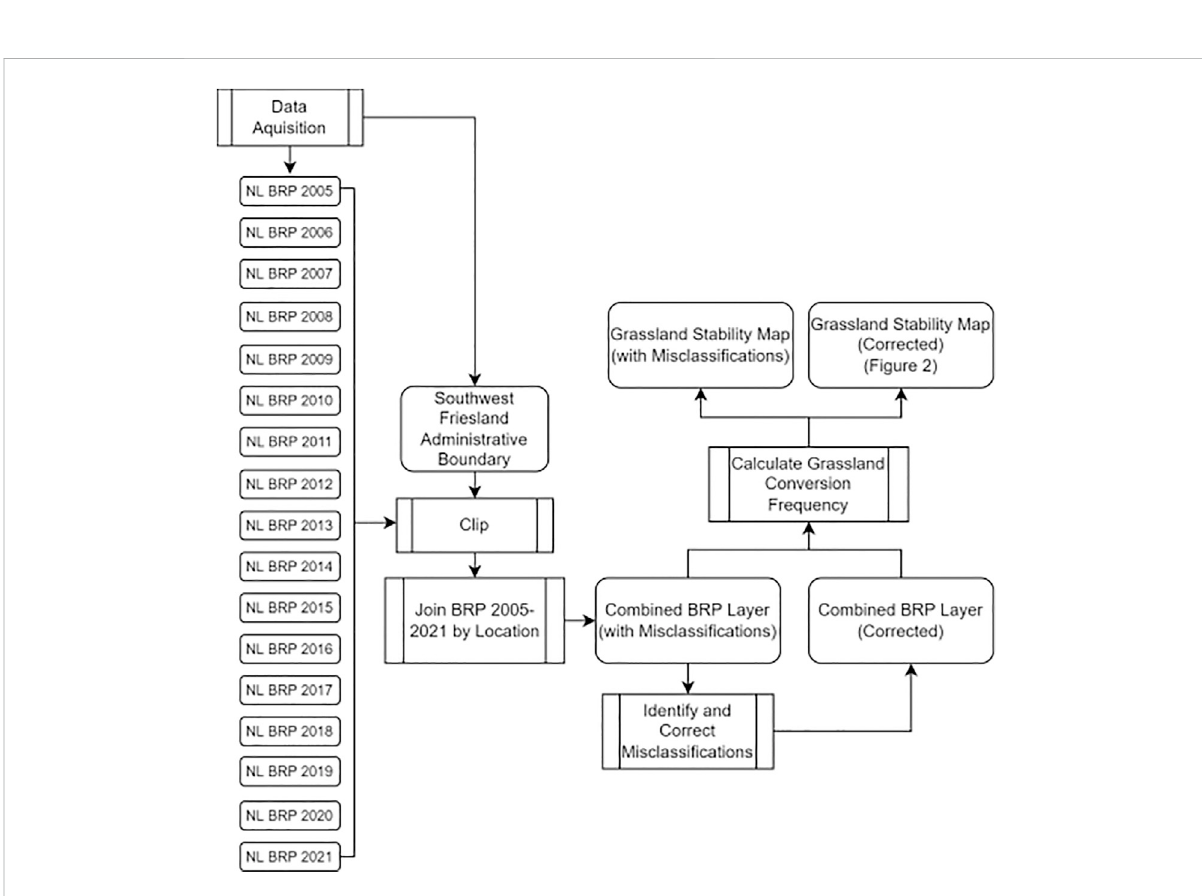
FIGURE 1 Generalized GIS-based work fl ow for calculating the frequency of grassland-to-cropland conversions in an intensive agriculture region of the Netherlands using open-source BRP land-use